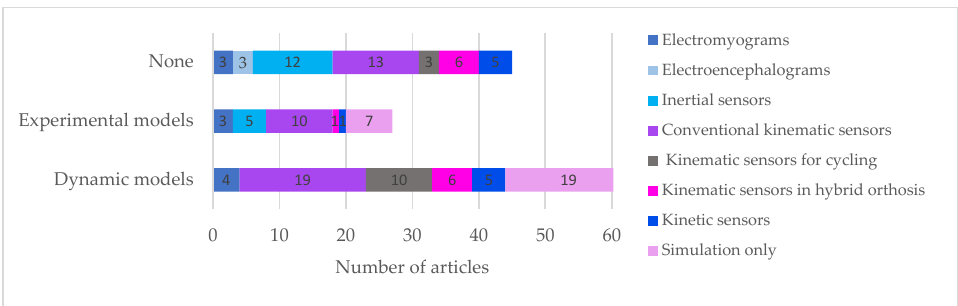
Figure 4. Overall overview for each category of sensor: ( a ) Electromyogramphy; ( b ) Inertial sensors; ( c ) Kinetic sensors. 1st Column: Modeling method; 2nd Column: Controlled variable; 3rd Column: Control Strategy. P: Proportional; I: Integral; D: Derivative [14,15,19 – 21,23,24,36 – 65].